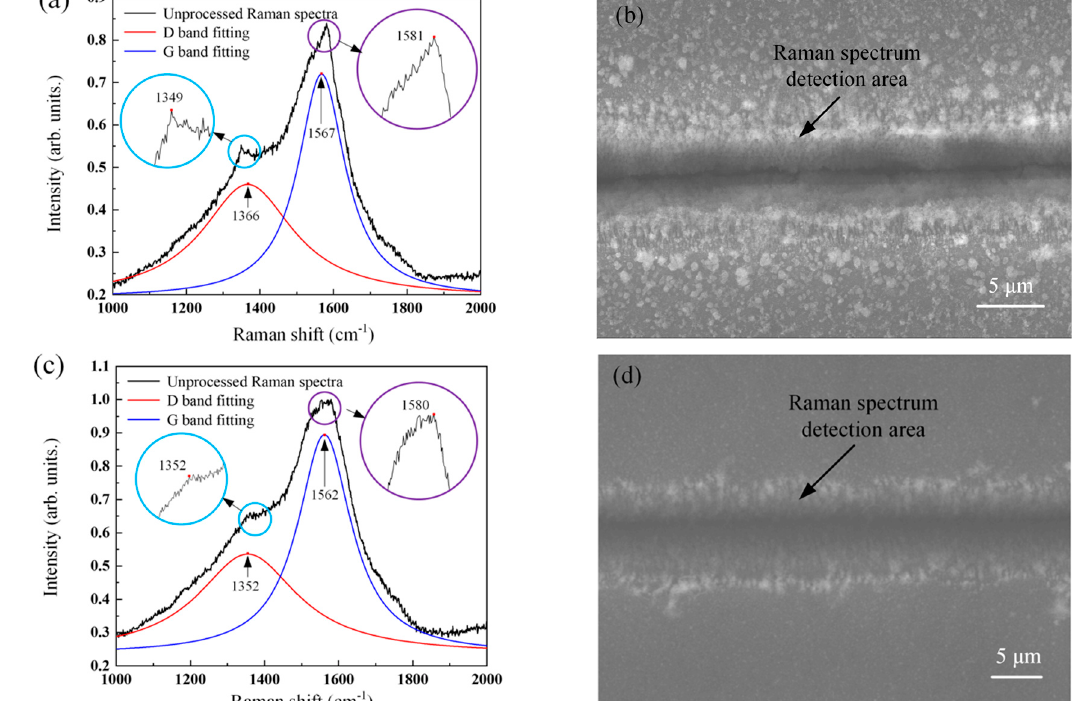
Figure 8. Raman detection and SEM image of the groove entrance of CNT film by laser cutting at different wavelengths under high pulse energy. ( a , b ) λ = 515 nm; ( c , d ) λ = 1030 nm.